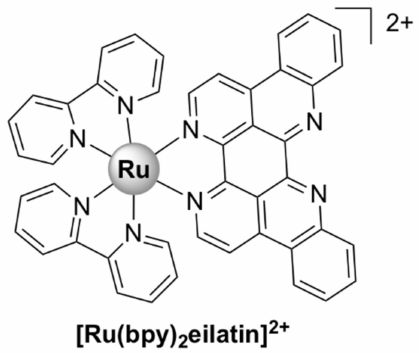
Figure 28. Chemical structure of [Ru(bpy) 2 eilatin] 2+